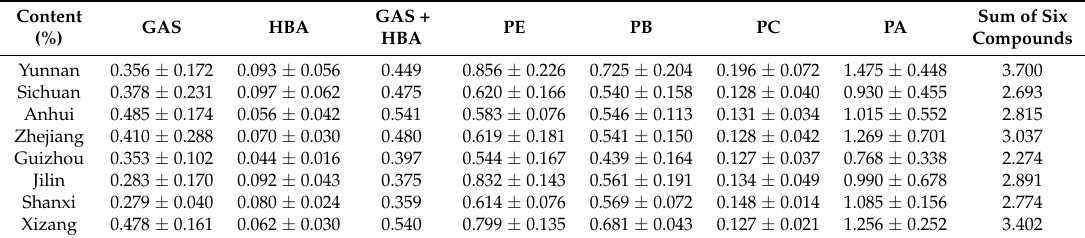
Table 3. The content of GAS, HBA, PE, PB, PC, PA and the sum in extract of G. elata